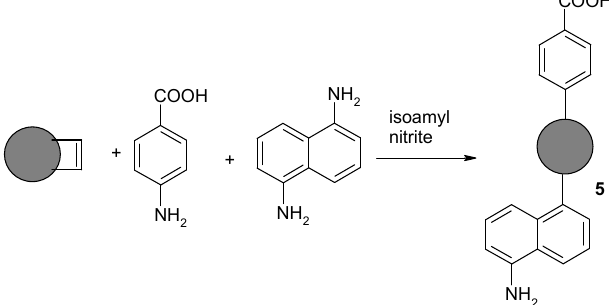
Figure 8. Reaction of olefinated NDPs with an isokinetic mixture of 1,5-diaminonaphthalene and p-aminobenzoic